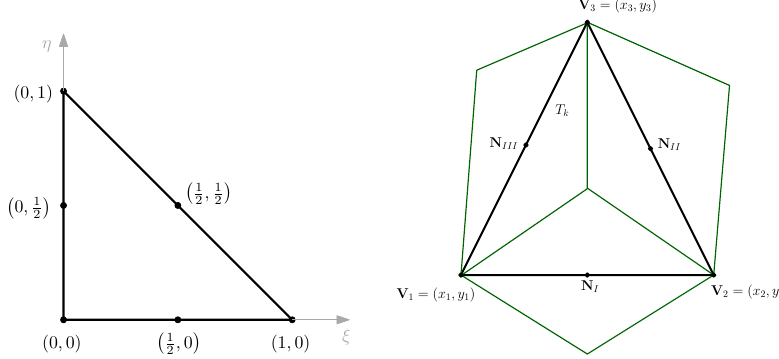
Figure 2. Reference triangle ( left ) and physical element ( right